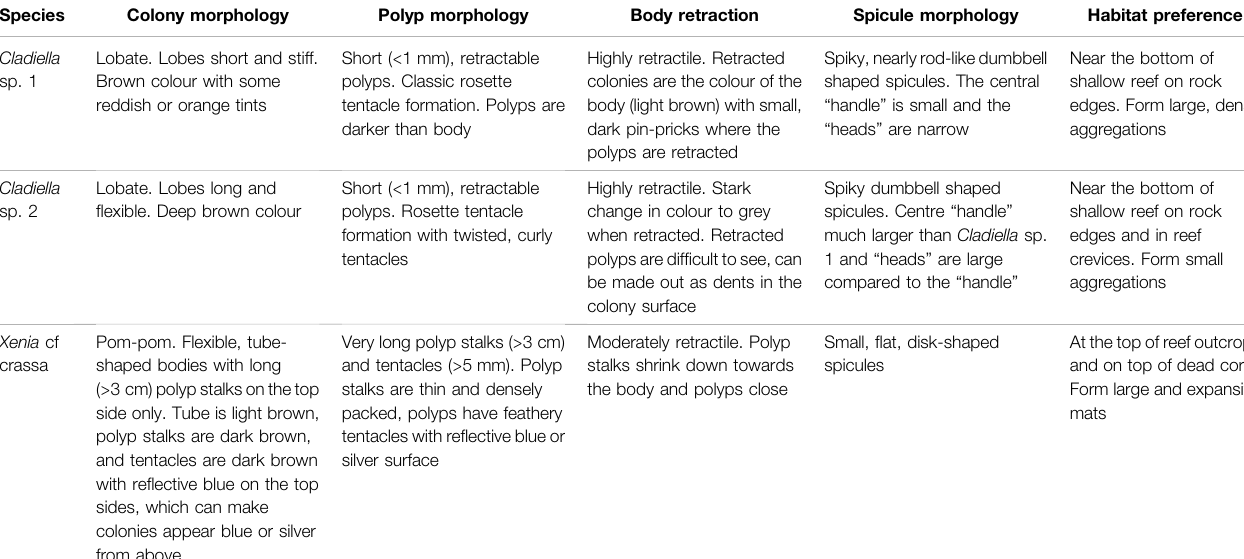
TABLE 1 | Summaries of study species morphological features and habitat preferences.